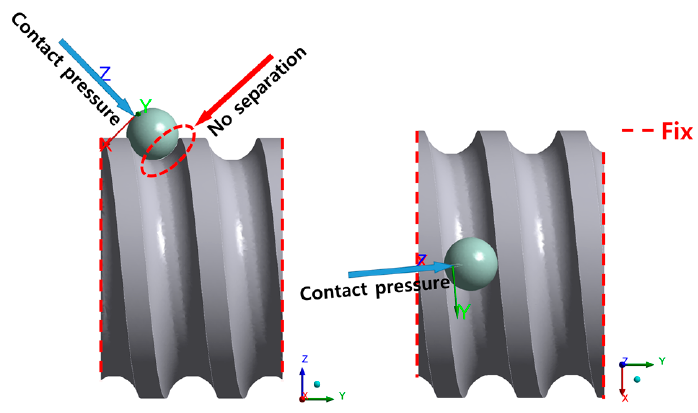
Figure 7. Boundary conditions of contact condition applied model.